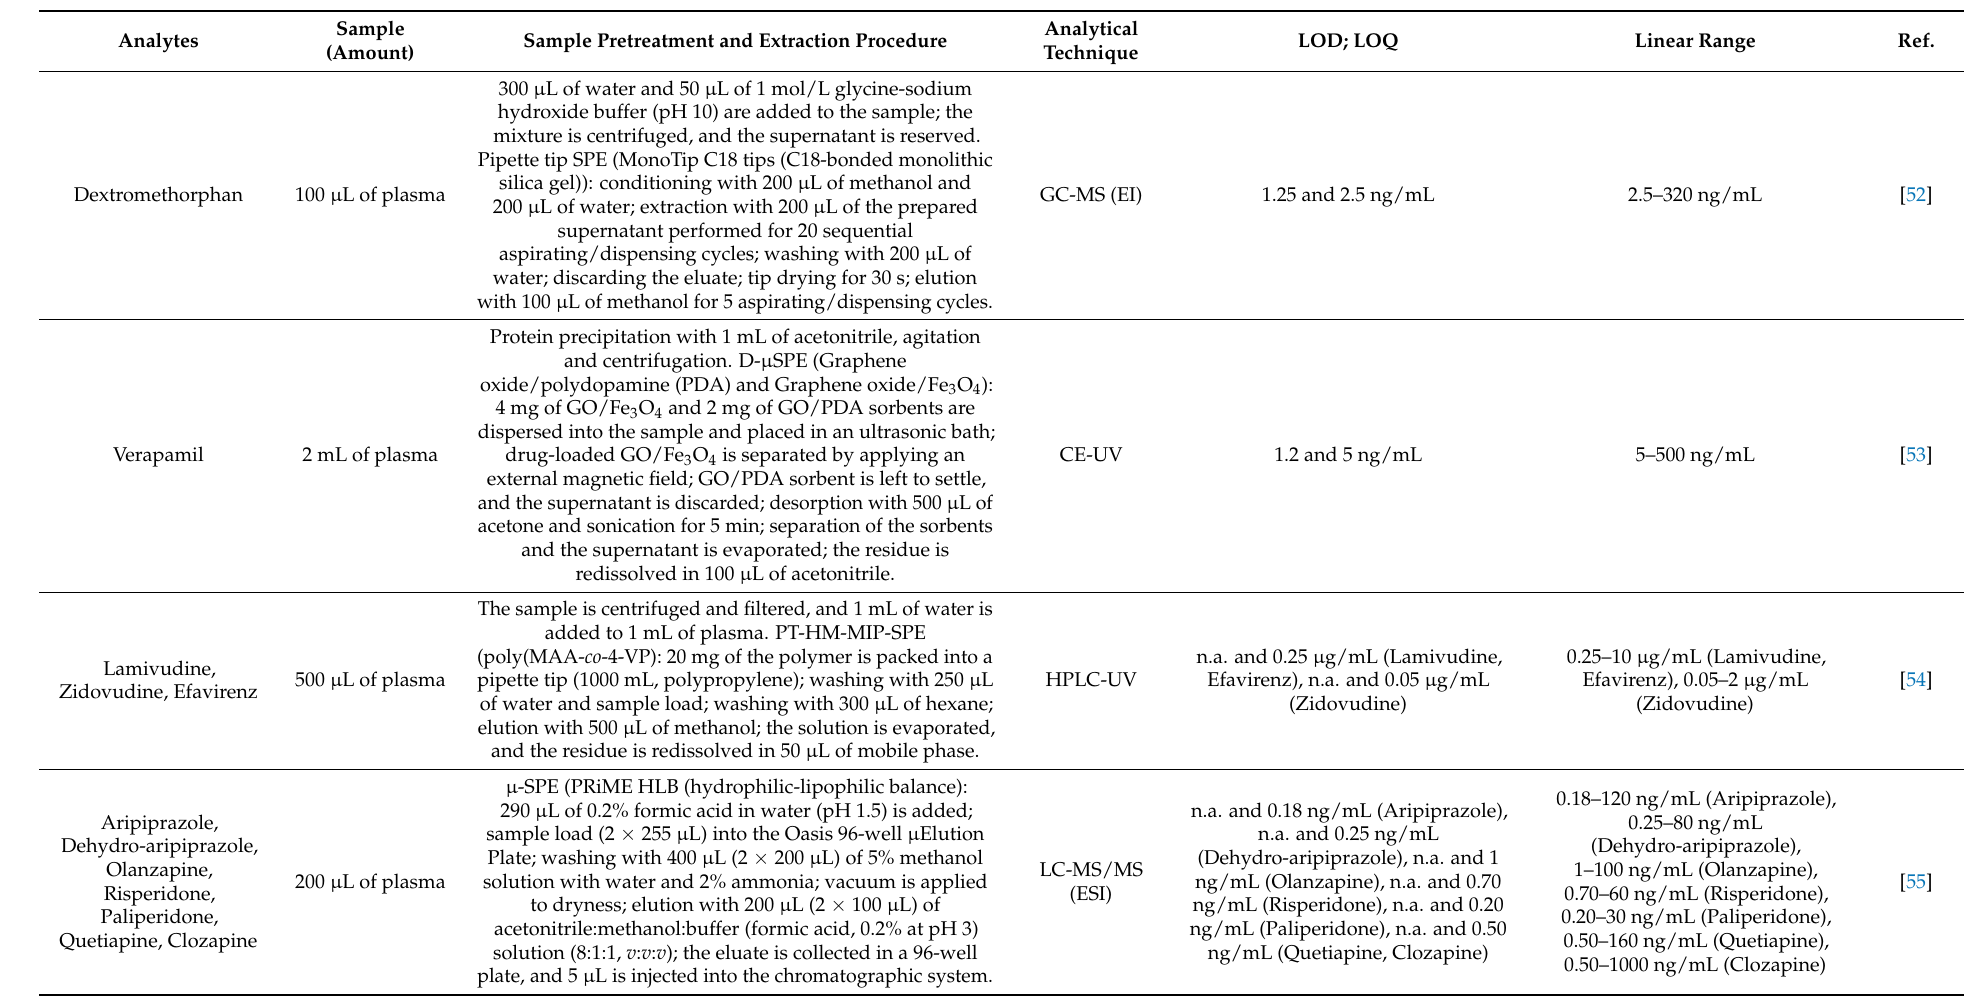
Table 6. Bioanalytical procedures using pipette tip SPE, µ -SPE and DSPE or MSPD approaches for